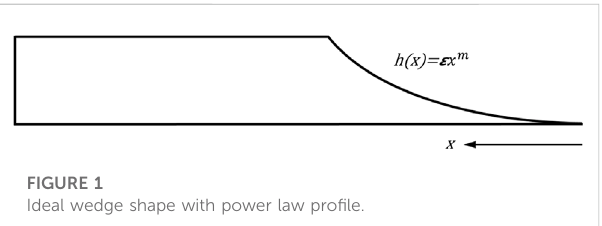
FIGURE 1 Ideal wedge shape with power law pro fi